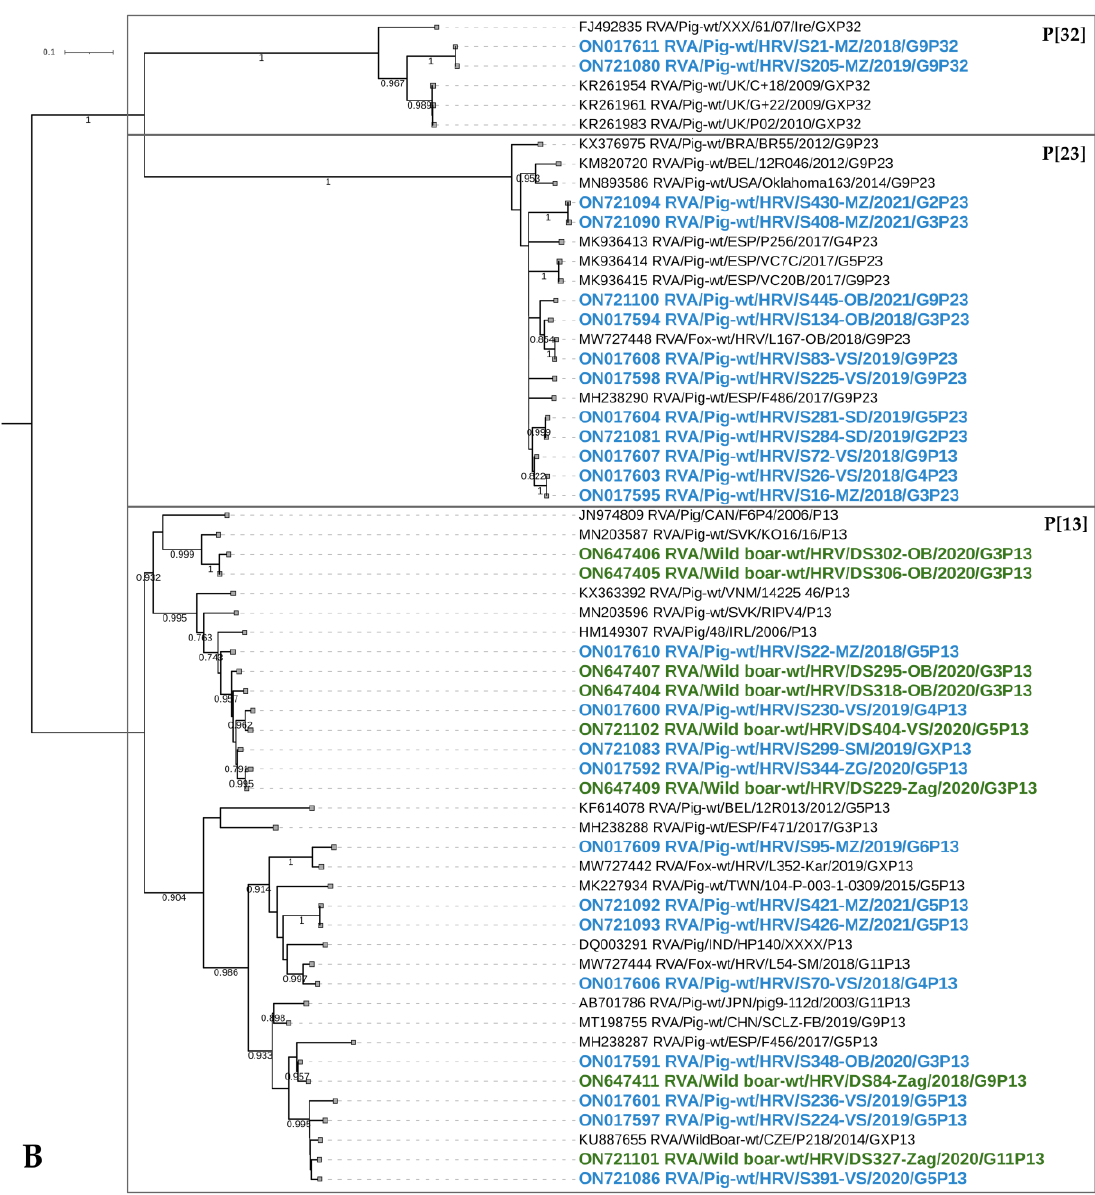
Figure 4. Phylogenetic relationship between RVA strains of P[6], P[7], P[8], P[11] ( A ) and P[13], P[23], P[32] ( B ) genotypes. The strains from the present study that were derived from domestic pigs and wild boars are marked in blue and green, respectively. The accession numbers of all strains, including referent strains from the GenBank, are designated within taxa. Based on the partial VP4 sequences (~650 nt), both trees were generated by the ML method and T92+G ( A ) or T92+G+I ( B ) model in MEGA 11 software. The branching stability of each phylogenetic tree was assessed by 1000 bootstrap replicates (values indicated adjacent to the nodes if >0.7). The scale bar represents the number of substitutions per site. In displaying RVA strain nomenclature within taxa, the brackets for the P genotype were omitted for the sake of